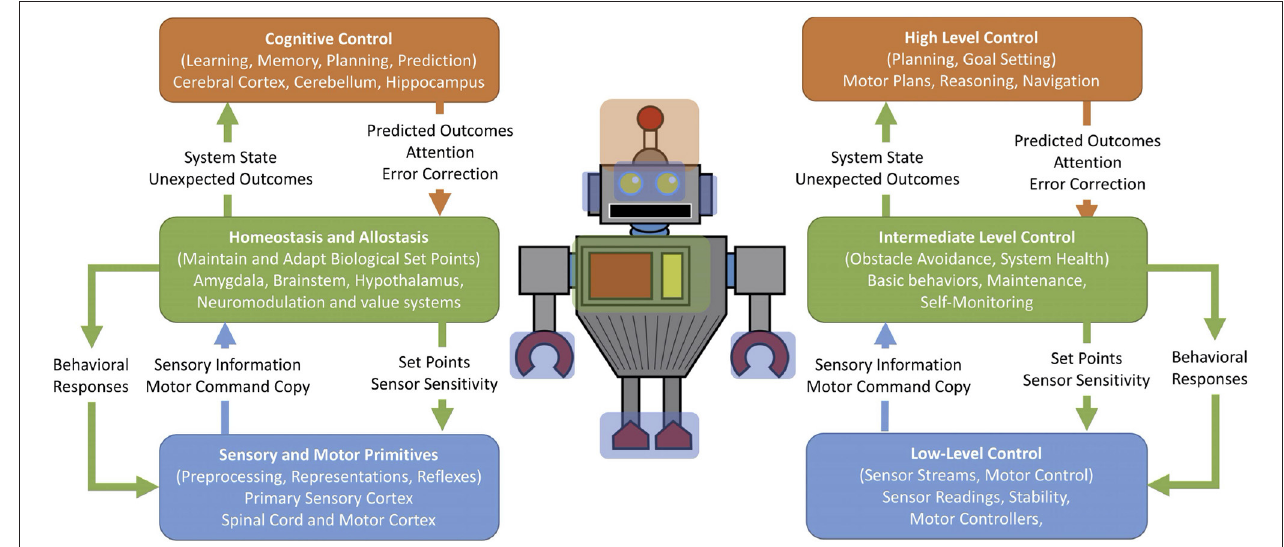
FIGURE 3 | Schematic for self-monitoring systems in biology and in engineering. On the left are terms and regions derived from neuroscience. On the right are terms adapted from autonomous robots but could be applied to many embedded systems. Blue: low-level sensory processing and motor control. Green: homeostasis, maintenance, and monitoring. Orange: high-level planning, adapting, and goal-driven behavior. Adapted from Chiba and Krichmar